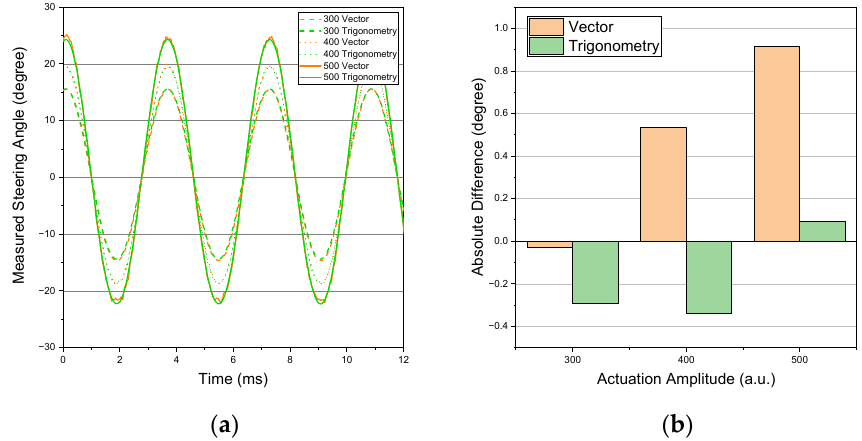
Figure 7. ( a ) Measured steering angles for three actuation amplitudes of 300, 400, and 500 a.u. calculated with the vector and the trigonometric approaches; ( b ) angular difference of the vector and trigonometric methods in comparison to the reference FoV measurement.